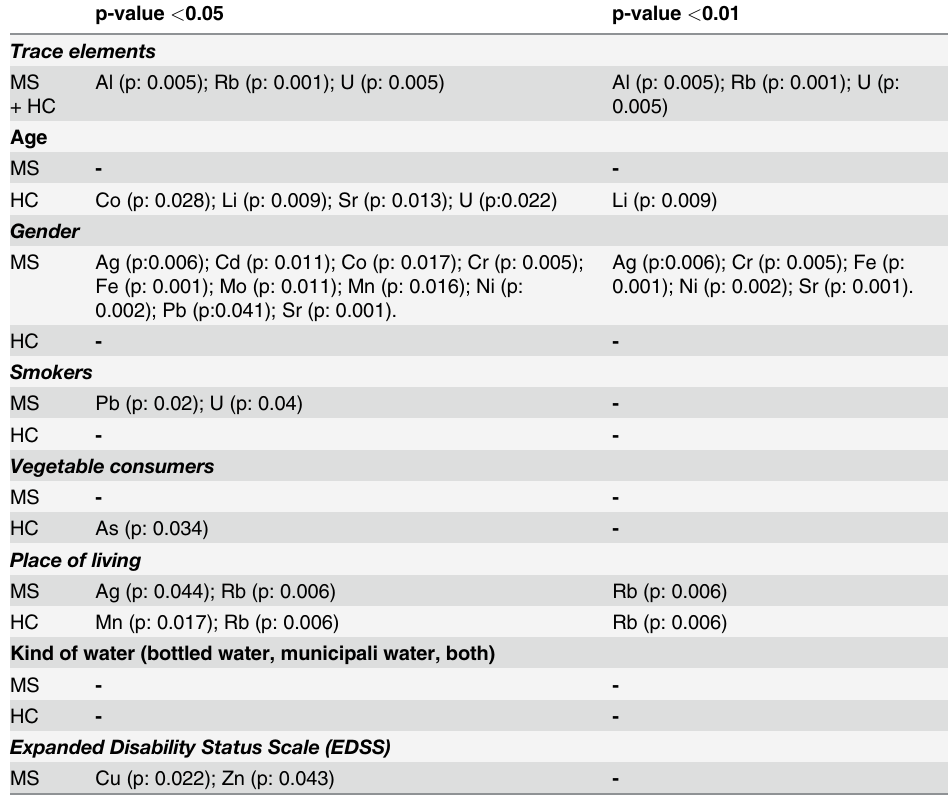
Table 4. Results of Mann-Whitney test for differences between MS patients, HC controls and con- founding variables. p-value <